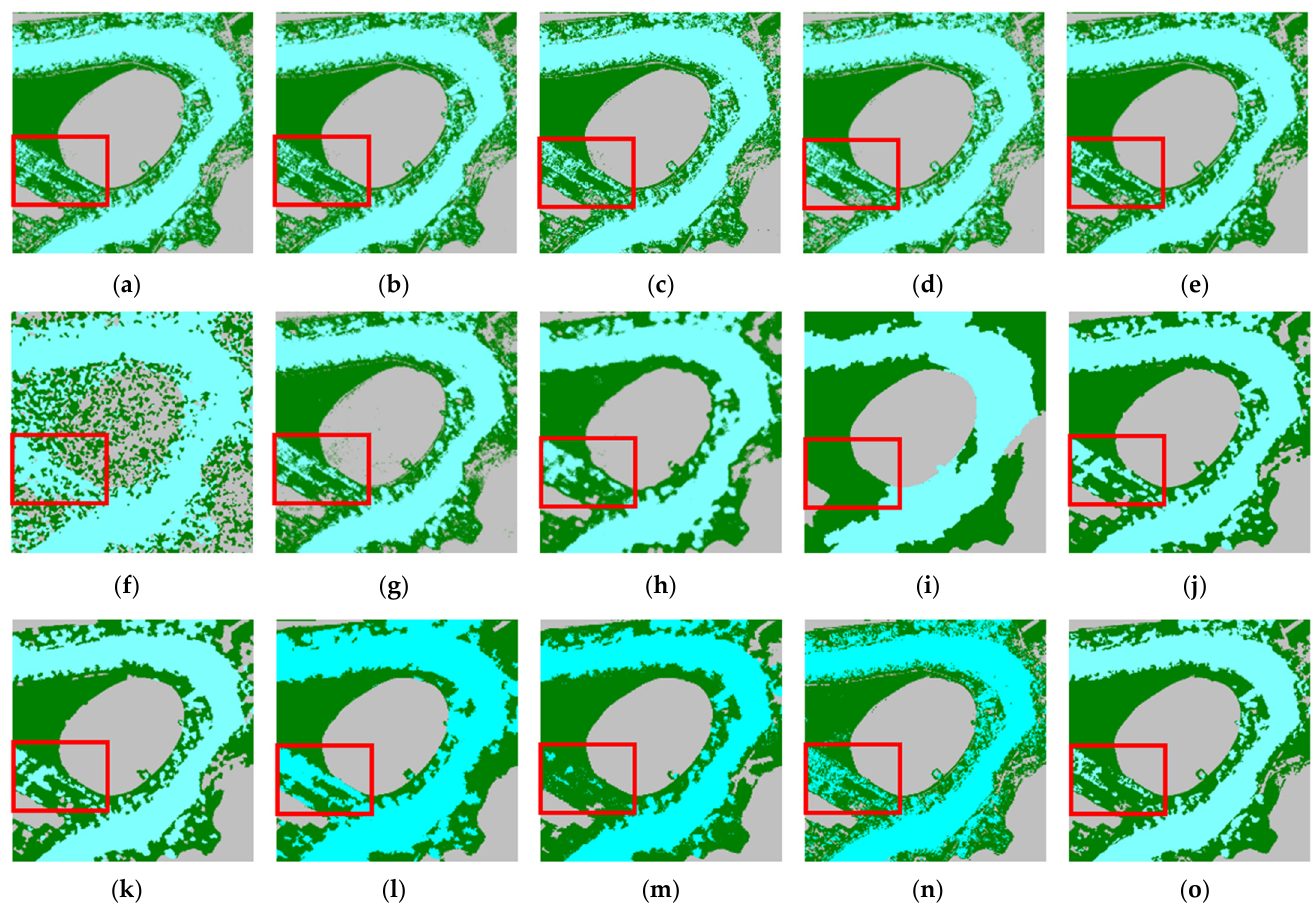
Figure 6. Experiment results of S3 images. The red rectangle boxes are selected as the comparison